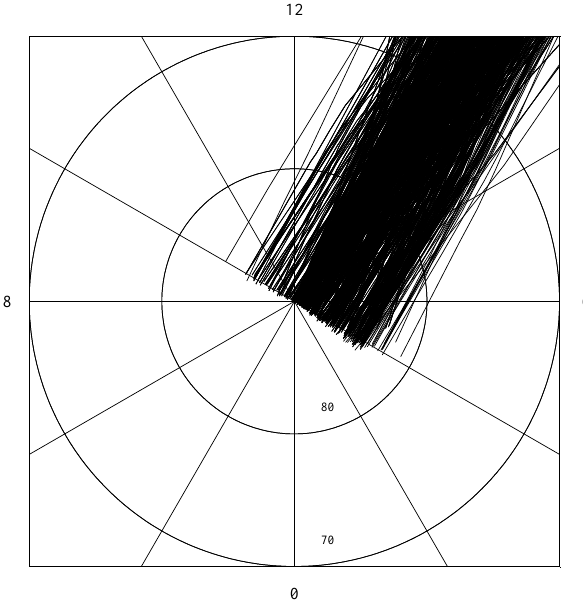
Fig. 2. Orbital segments of DMSP-F7 satellite along which two- or three-sheet structures were observed in the Northern and Southern